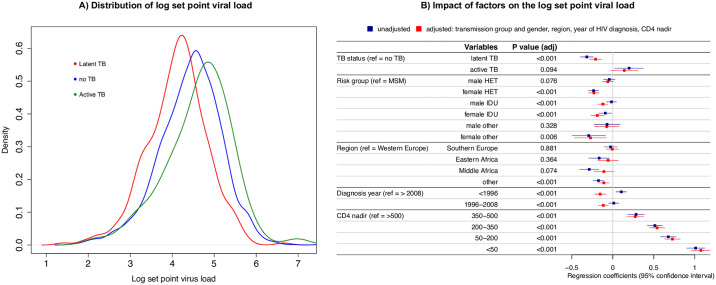
(A) Distribution of HIV SPVL values (log RNA) for patients with LTBI, active TB, and MTB uninfected patients. The lines indicated the density function of the log RNA values in the 3 studied groups. (B) Association of various factors with the log set point virus load; the lines indicate the 95% CIs obtained in the regression model; the dots indicate the regression coefficients. (see S3 Data for the underlying numerical values) CI, confidence interval; HET, heterosexual; IDU, intravenous drug users; LTBI, latent tuberculosis infection; MSM, men who have sex with men; MTB, Mycobacterium tuberculosis; SPVL, set point viral load; TB, tuberculosis.